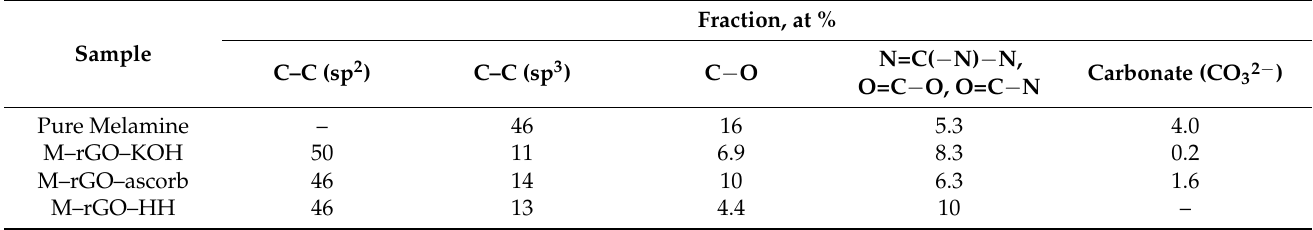
Figure 9. C1s XPS spectra of melamine – rGO composites. Table 3. Contents of different carbon species on the surface of melamine and melamine-based composites determined by XPS.